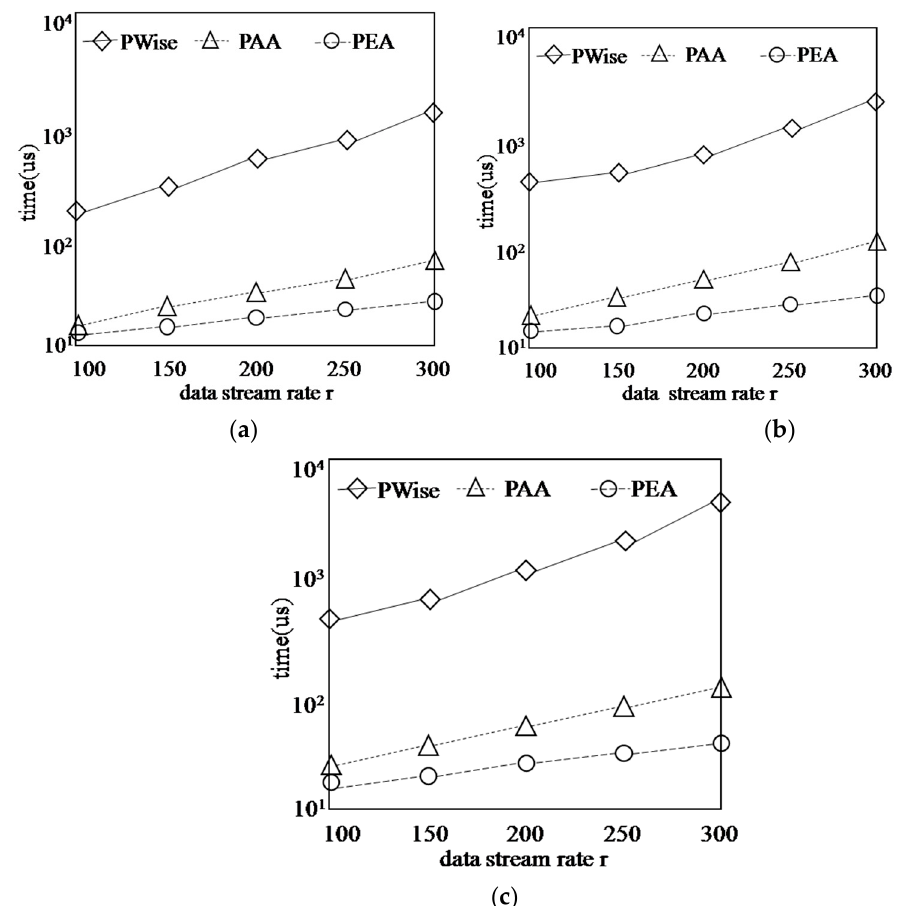
Figure 17. Finding G-Skyline with different data stream rate r . ( a ) COR; ( b ) IND; ( c ) ANTI-COR.